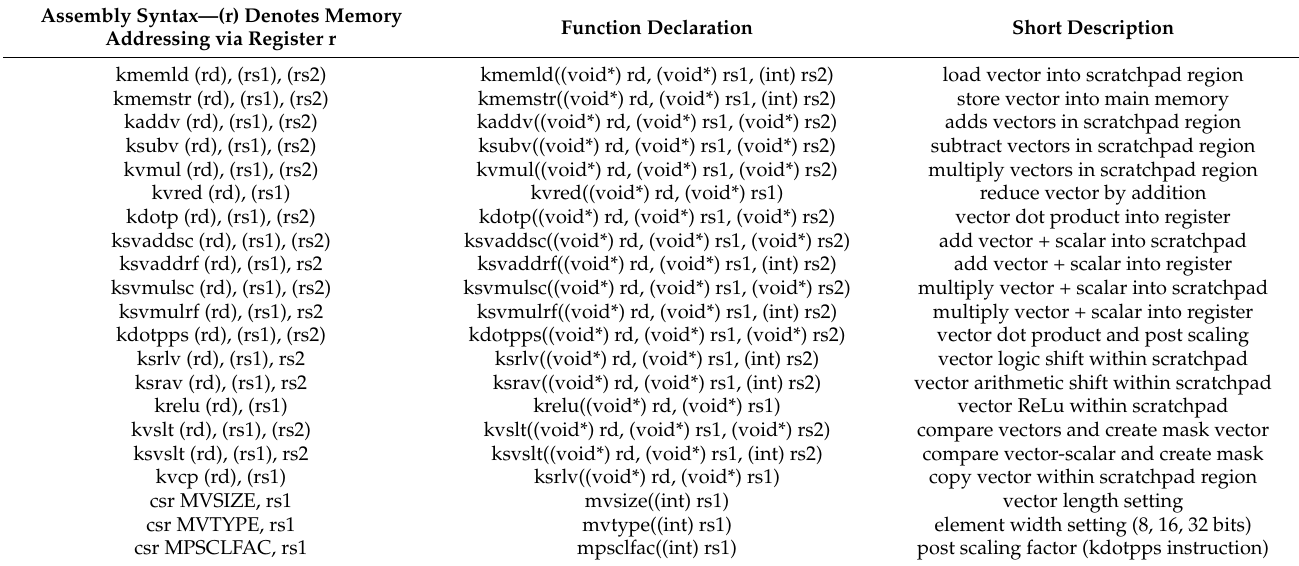
Table 2. RISC-V instruction set custom extension for Klessydra-T